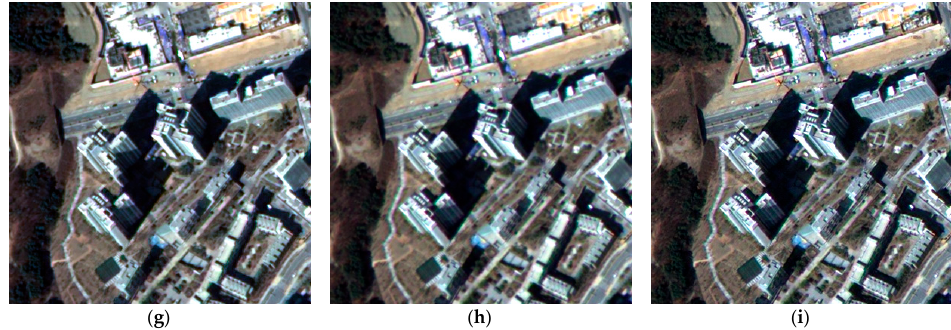
Figure 7. The 400 × 400 details of KOMPSAT-3 true-color (red, green, and blue) composites: ( a ) panchromatic image; ( b ) EXP ; ( c ) GIHS ; ( d ) GSA G ; ( e ) GSA L ; ( f ) BDSD ; ( g ) NNDiffuse ; ( h ) HP-NDVI spectral ; ( i ) HP-NDVI spatial . Remote Sens. 2017 , 10 , 976